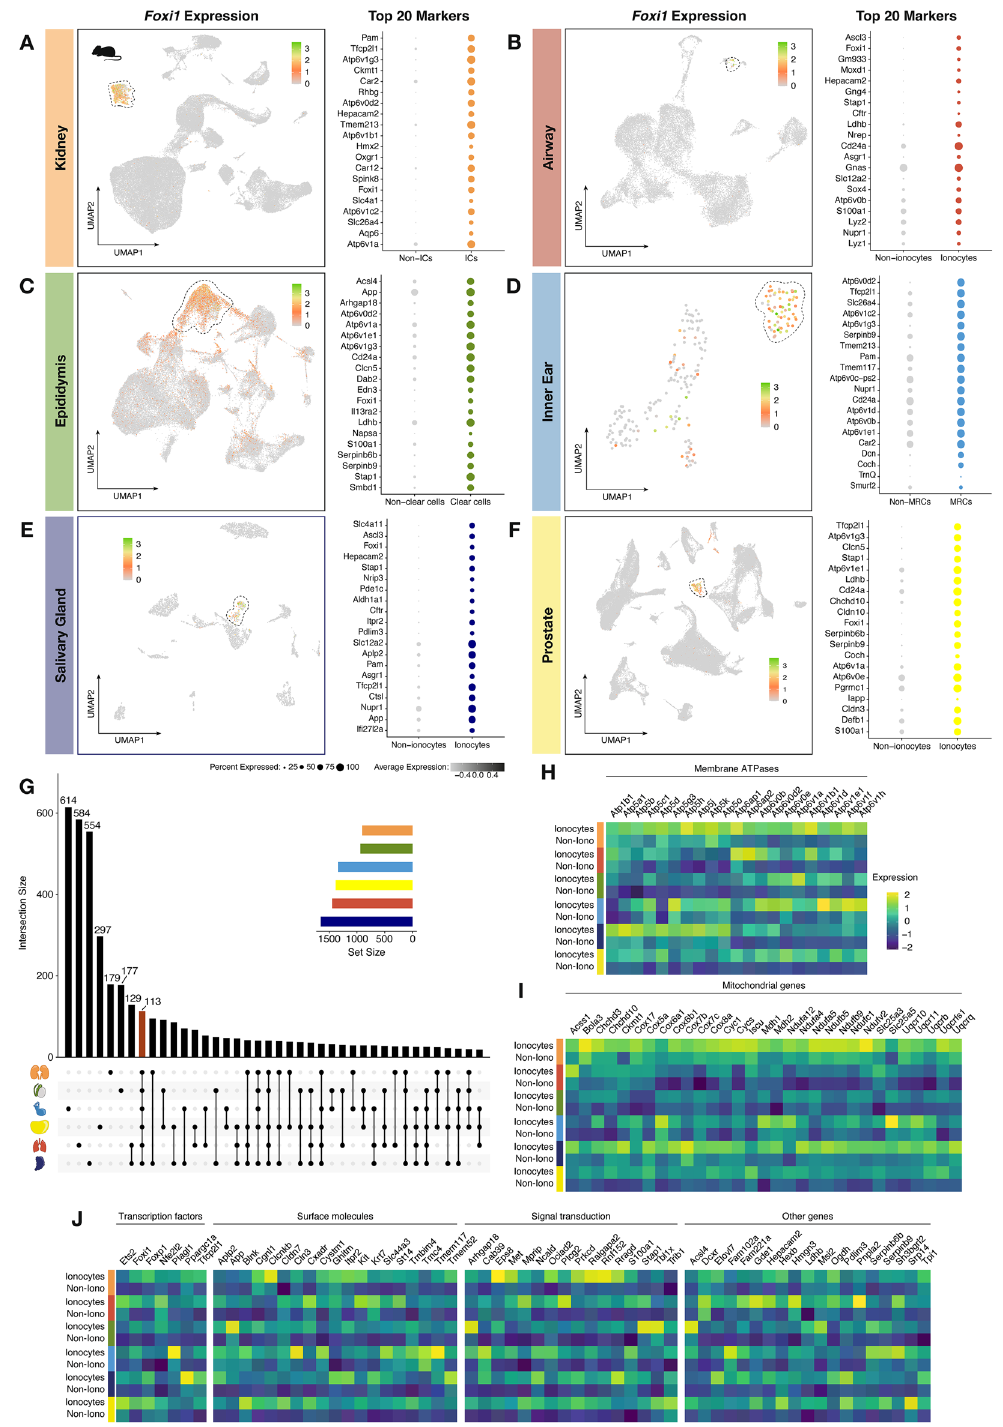
Figure 5. Murine ionocyte identification and comparison. Depicted are feature plots from datasets of murine tissues ( A : kidney, B : airway, C : epididymis, D : inner ear, E : salivary gland, F : prostate), showing the presence of ionocyte clusters ( Foxi1 -expressing cells). Next to each feature plot, we show the top 20 differentially expressed genes (DEGs) per ionocyte population. ( G ) Bar graph revealing the intersecting DEGs between ionocyte populations. The 113 genes commonly shared in all five ionocyte populations can be observed in the heatmaps, which were divided by category ( H , membrane ATPases; I , mitochondrial genes; J , transcription factors, surface molecules, signal transduction-related genes, and other